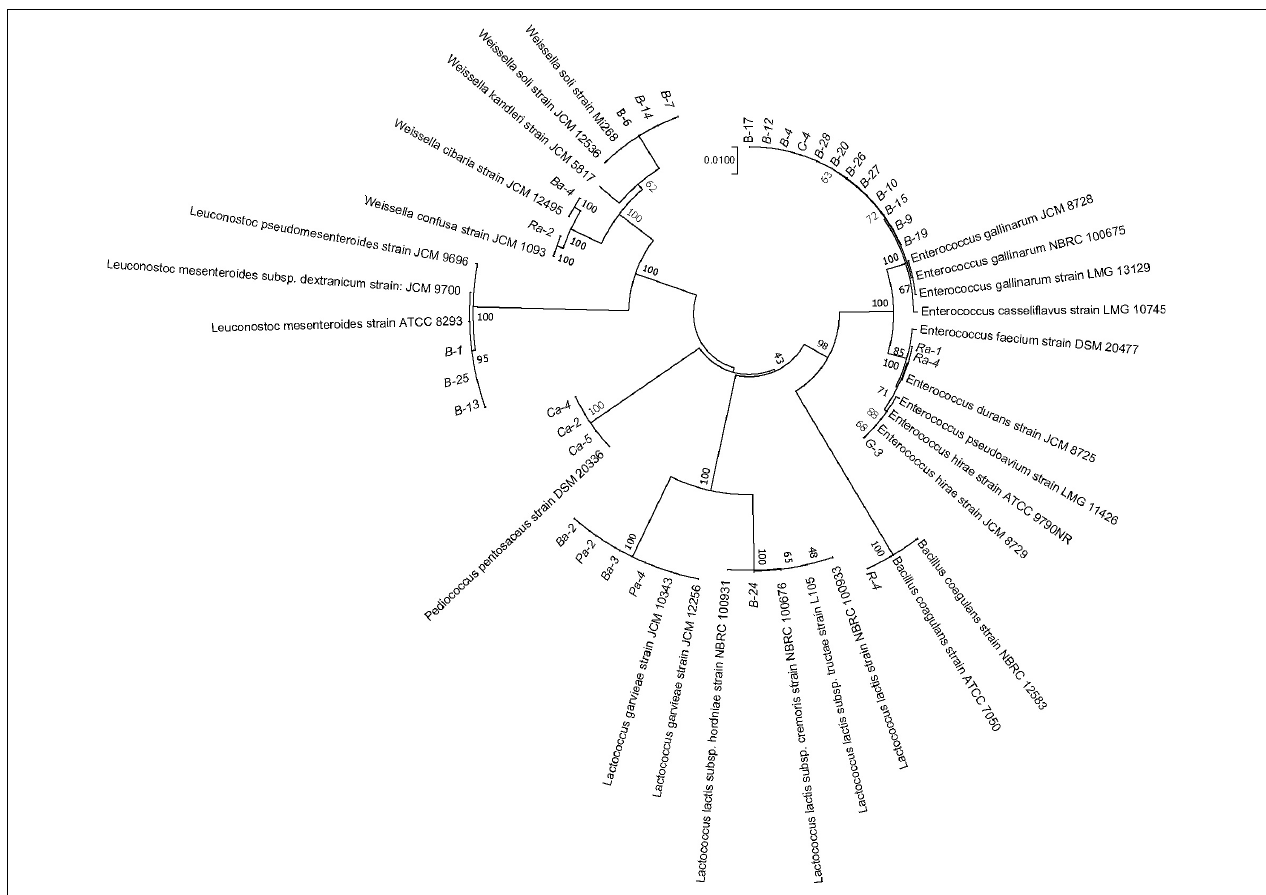
FIGURE 4 | Phylogenetic tree constructed with sequences of the partial 16S rRNA gene of selected LAB strains. The 16S sequences of the isolated bacteria are aligned with reference strains. The data of type strains of related species were from GenBank database. Branch lengths are proportional to distance. Bootstrap values are indicated near the internodes. B, R, C, G, and P represent juices of broccoli, radish, cherry, ginger, and pitaya, respectively; Ba, Ra, Ca, Ga, and Pa represent juices of broccoli, radish, cherry, ginger, and pitaya after fermentation,